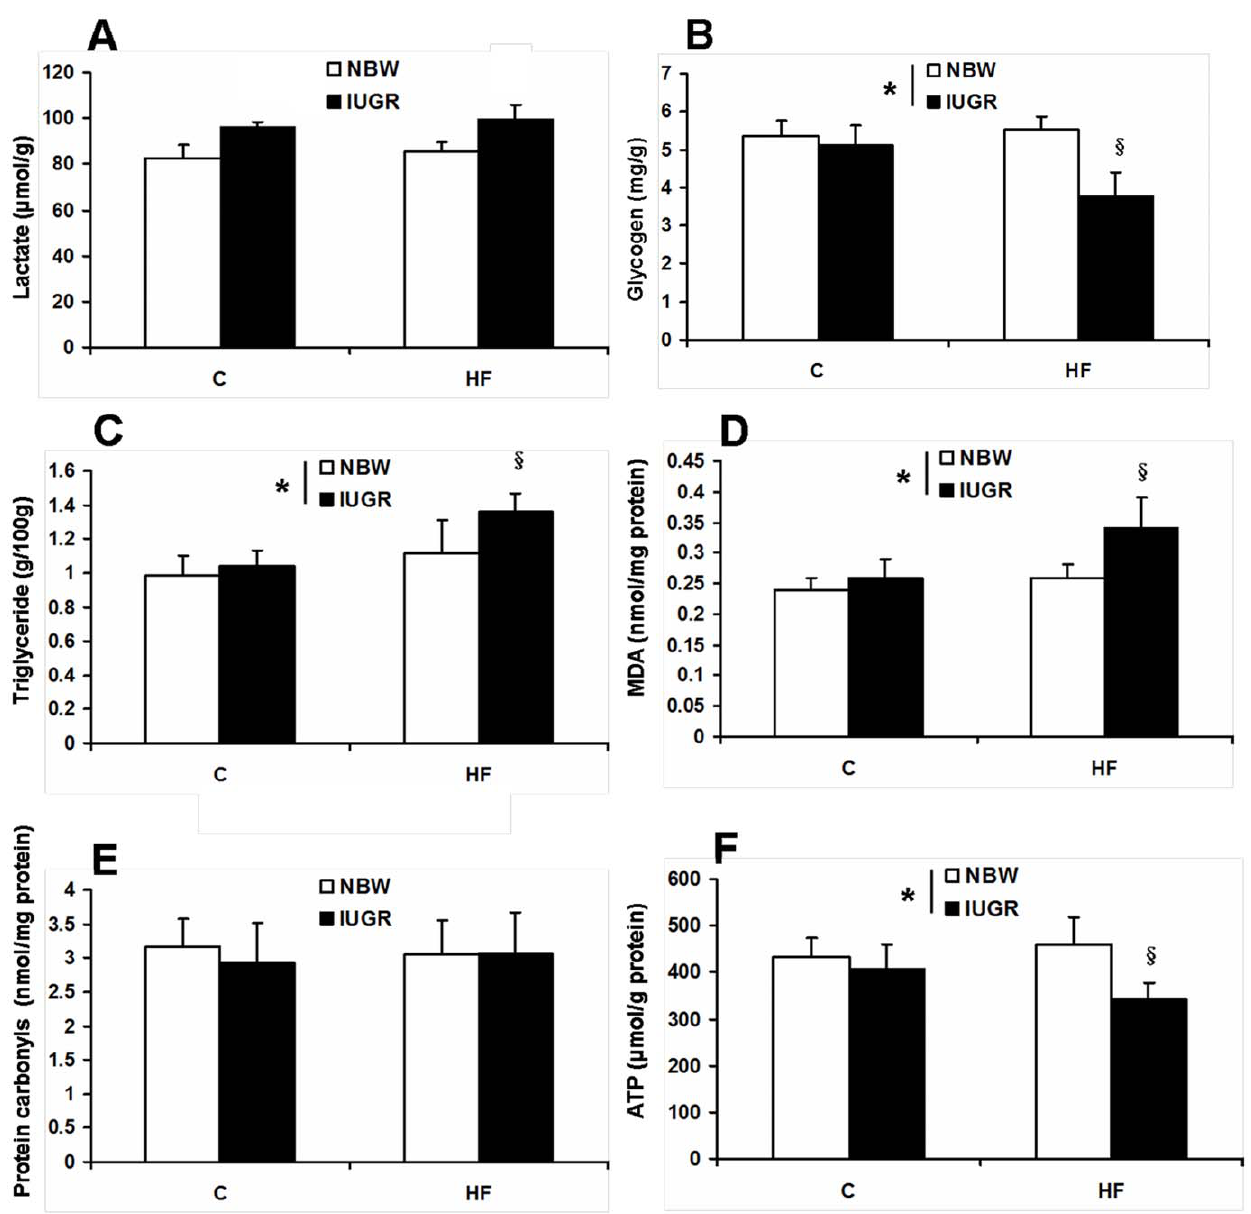
Figure 3. Influence of IUGR and diet on concentrations of lactate (A), glycogen (B), triglyceride (C), MDA (D), protein carbonyls (E) and ATP (F) in skeletal muscle of pigs. C: Control diet; HF: High-fat diet; NBW: Normal birth weight; IUGR: Intrauterine growth retardation. Data are expressed as group means 6 SEM. * P values next to each label represent the significance in the effect for each source of variation (IUGR or diet) as calculated by ANOVA. 1 P , 0.05 in post hoc test comparing IUGR and NBW offspring receiving the same diet (n=8 by group).